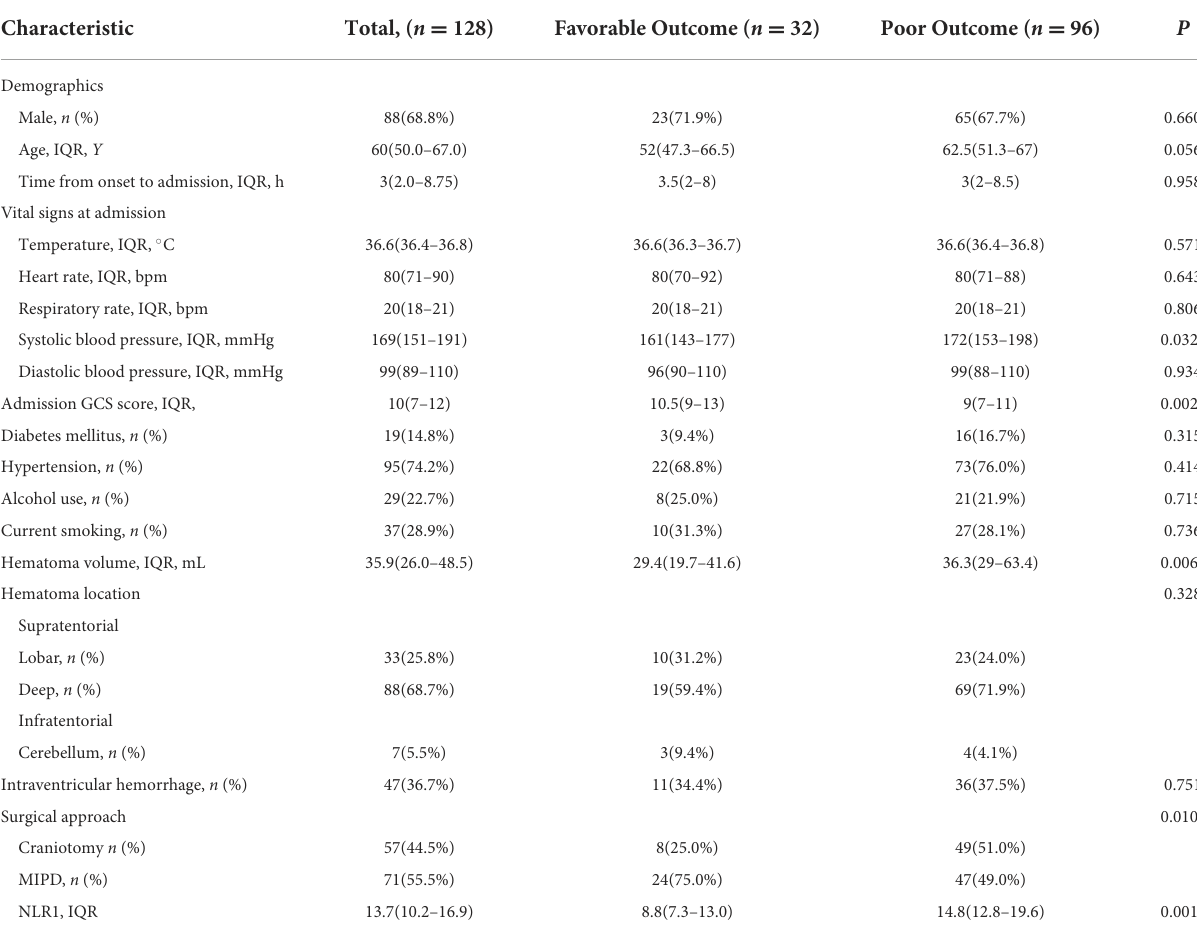
TABLE 1 Baseline characteristics related to the 30-day outcome in surgical patients with ICH.